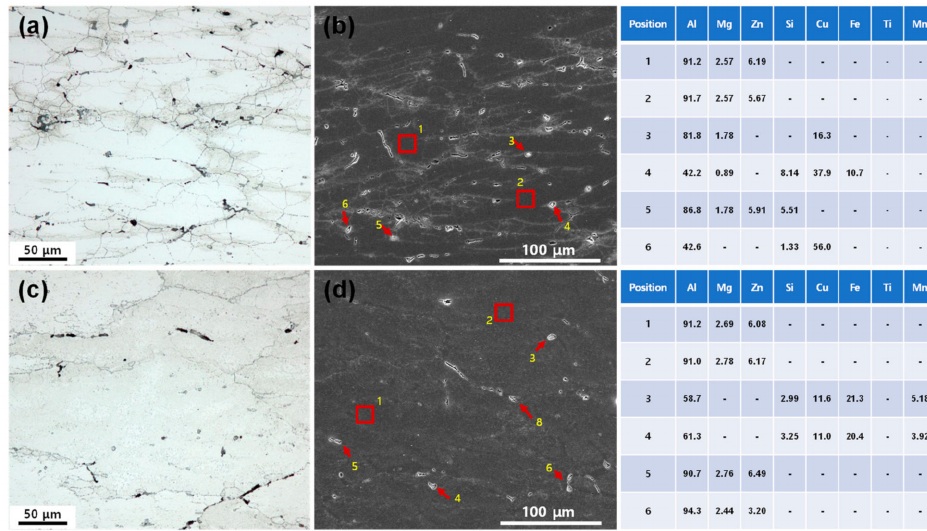
Figure 10. The optical and SEM micrographs of the ( a , b ) as-cast and ( c , d ) extruded alloys after compression tests at 723 K–10 − 3 s − 1 . The inserted tables represent the EDS analysis results.